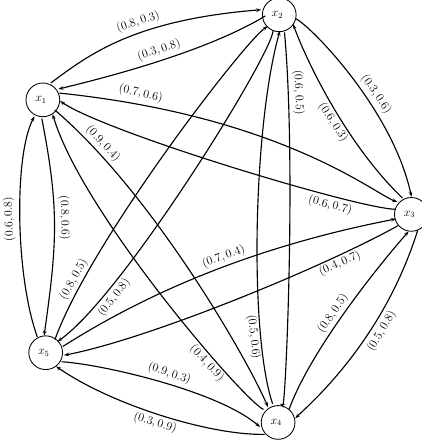
Figure 11. Directed network of the Pythagorean fuzzy preference relation